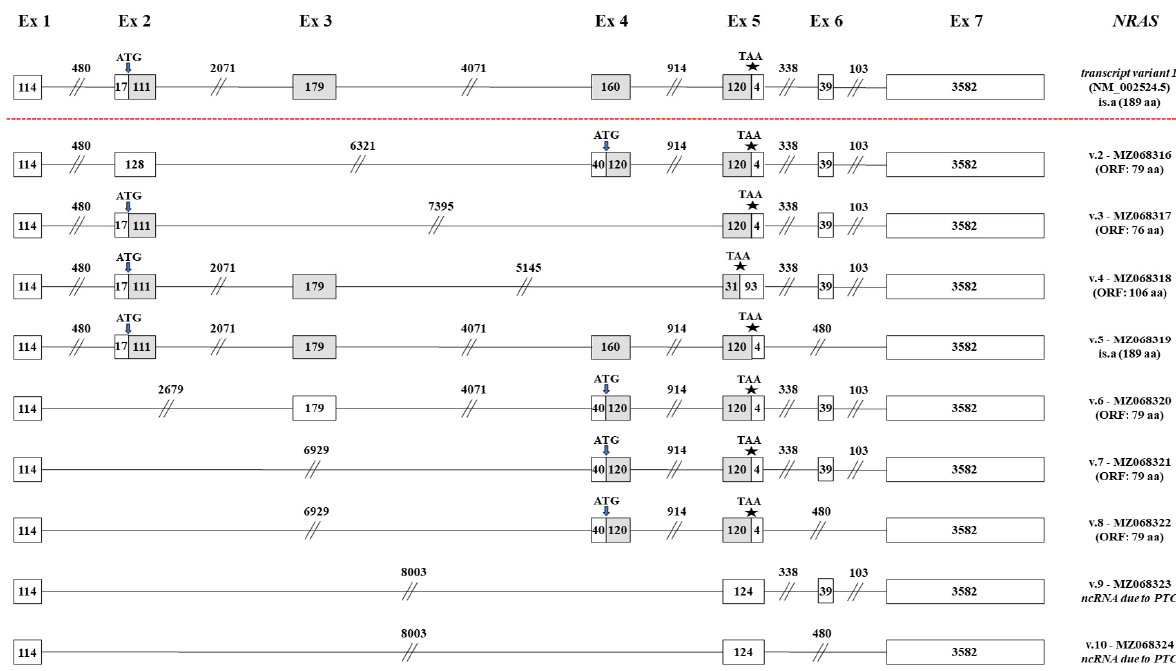
Figure 3. Detailed structural demonstration of the 9 novel NRAS transcript variants ( NRAS v.2 – v.10) identified in the current study. Exons are exhibited as boxes and introns as lines, while the numbers that characterize every box and line correspond to their length in nucleotides. Gray and white boxes represent coding and non-coding regions, respectively. The positions of the ATG and stop codons are pointed out with arrows ( ↓ ) and asterisks (*), accordingly.